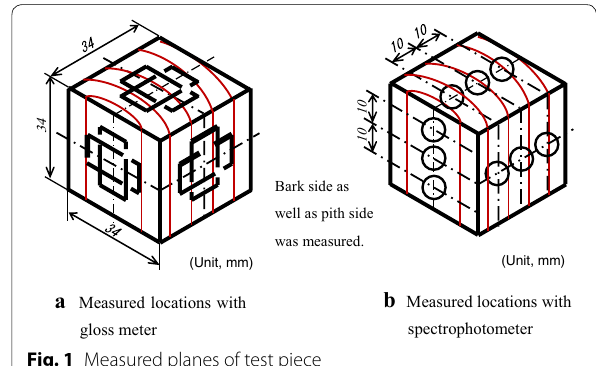
Fig. 1 Measured planes of test